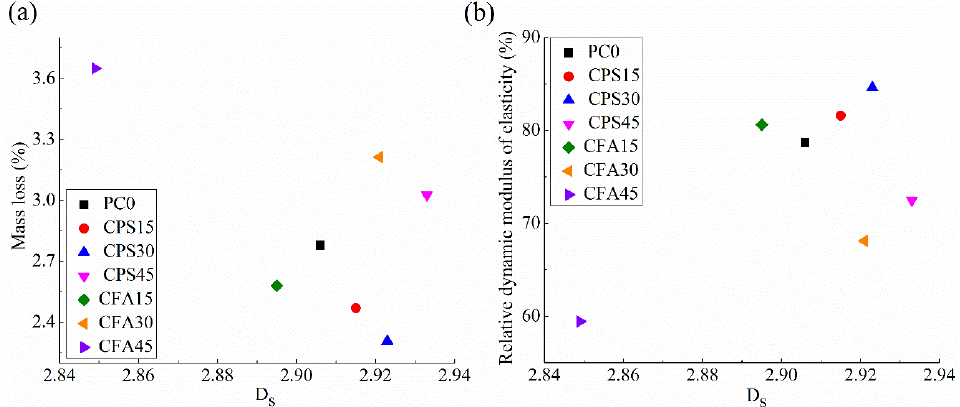
Figure 8. The correlation between frost resistance and D s ( a ) mass loss and D s and ( b ) relative dynamic elastic modulus and D s .